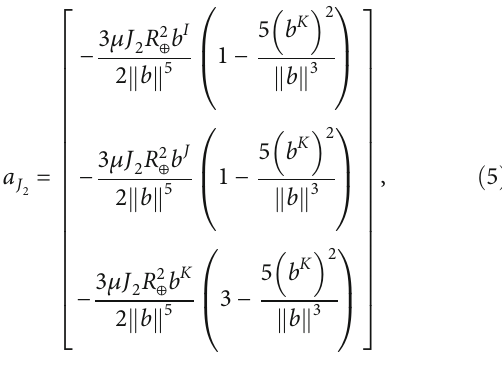
Figure 1: Illustration of coordinates for spacecraft